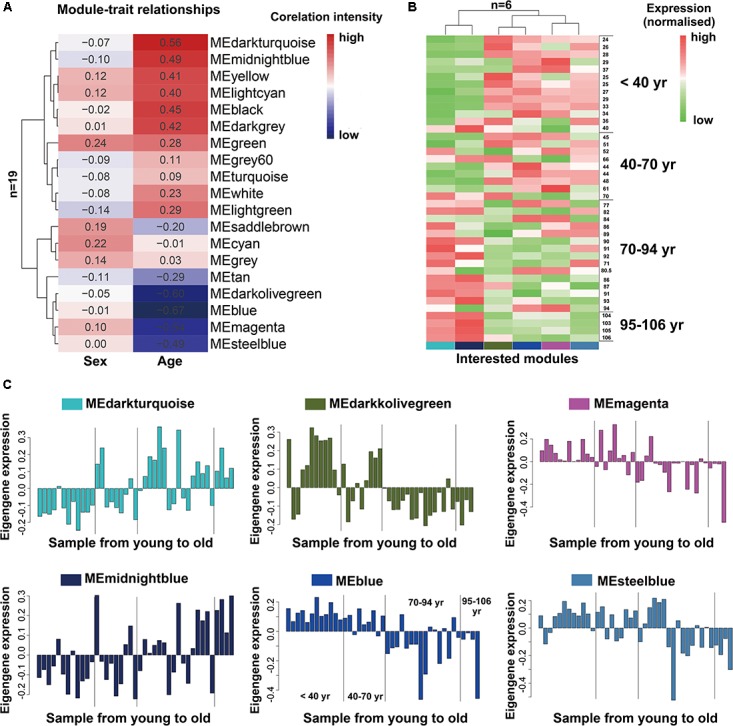
Module-trait and the gene expression of interested modules in the aging human prefrontal cortex. (A) Supervised hierarchical cluster of each row correspond to a module eigengene (n = 19), column to a trait. Each cell contained the corresponding correlation. High correlations was colored in red, low correlation in blue. (B) Hierarchical cluster analysis of six interested modules, based on the module-trait’s correlation and p value (absolute r > 0.5, P < 10–2), four modules (blue, darkolivegreen, magenta, steelbule) showed relatively high expression in young adults (red) and lower expression (green) in the aging population. Conversely, the other two modules (darkturquoise and midnightblue) showed the opposite result. Each lane represented an individual prefrontal cortical brain sample. (C) The histograms described the eigengene expression of each module from young to old.